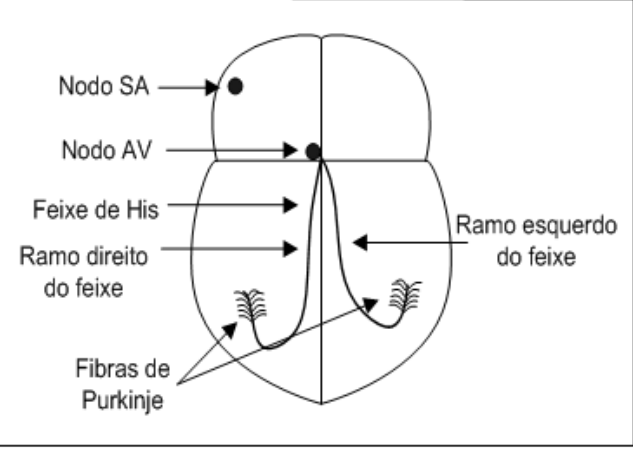
Figura 2. Sistema de condução da atividade elétrica do coração Os artefatos no ECG podem ser de origem fisiológica e técnica (por exemplo, os artefatos devido ao movimento do paciente). Para atingir o critério anterior é necessário realizar um reconhecimento morfológico automatizado, batimento a batimento no sinal de ECG, que valide os batimentos validos (normais) e não validos (a partir daqui denominados de artefatos). Por